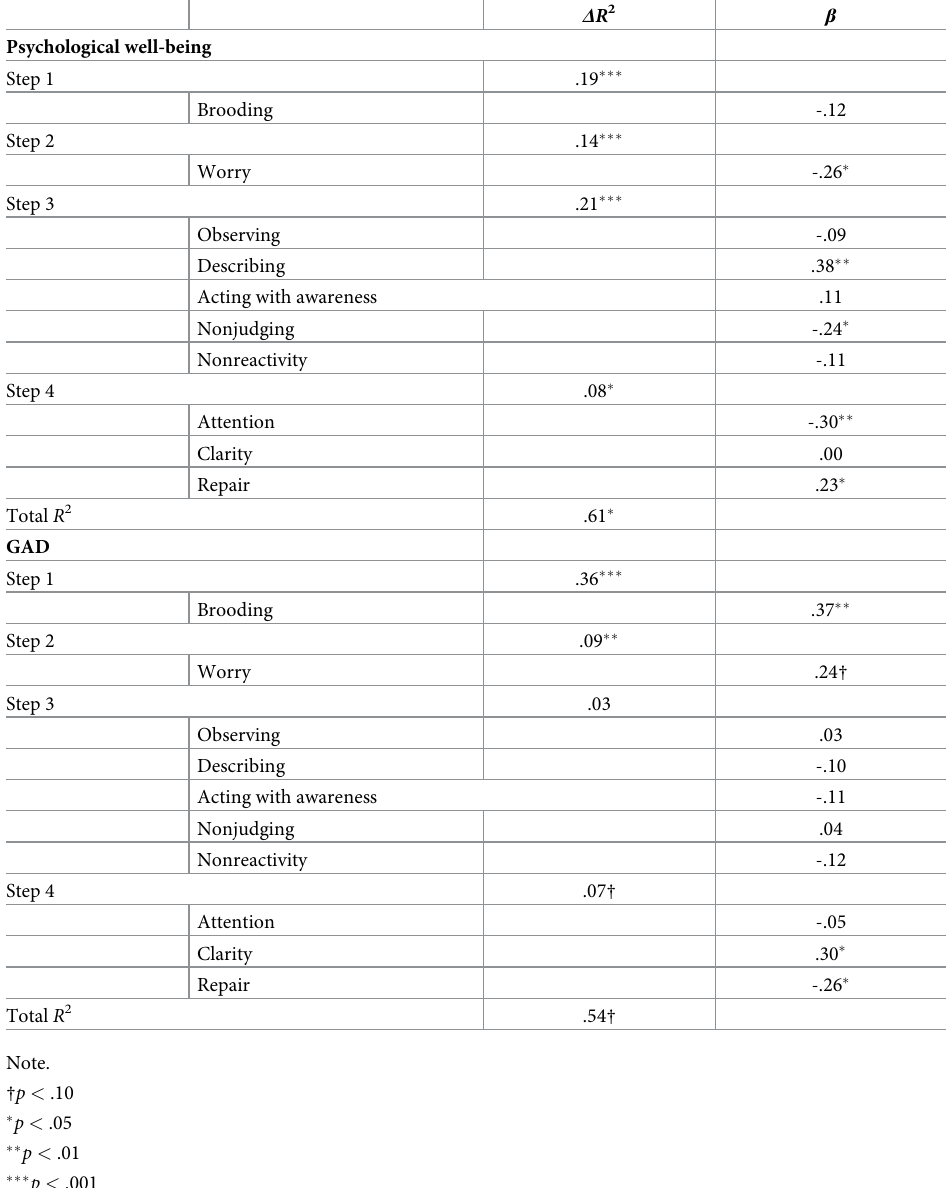
Table 2. Hierarchical regression analysis for variables associated with psychological well-being and anxiety symp- toms: Model 4.